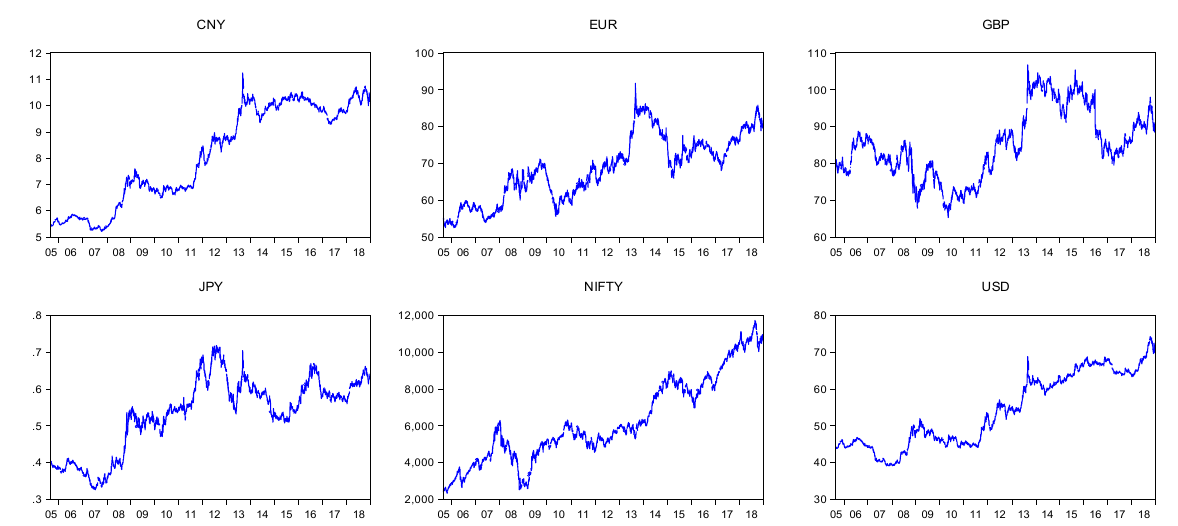
Figure 1. Line plots of the variables over the study period.